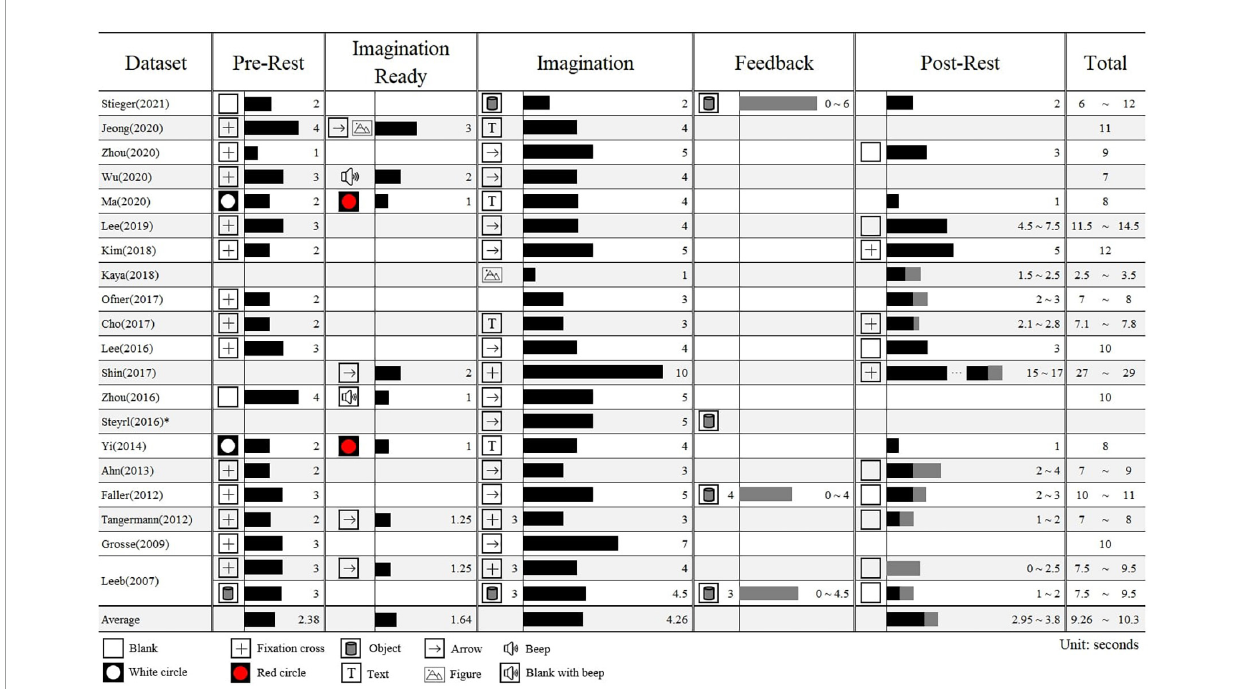
FIGURE2 The block information of a trial in each motor imagery dataset. The timings are based on the bagging of pre-rest (0 s). The number next to the stimuli represents the timing when it appeared and the number next to the bar represents the duration of the block in seconds. The gray bar indicates the adjustable time within sub-blocks. *Only the duration of the imagination is provided due to the lack of information in Steyrl et al. (2016).